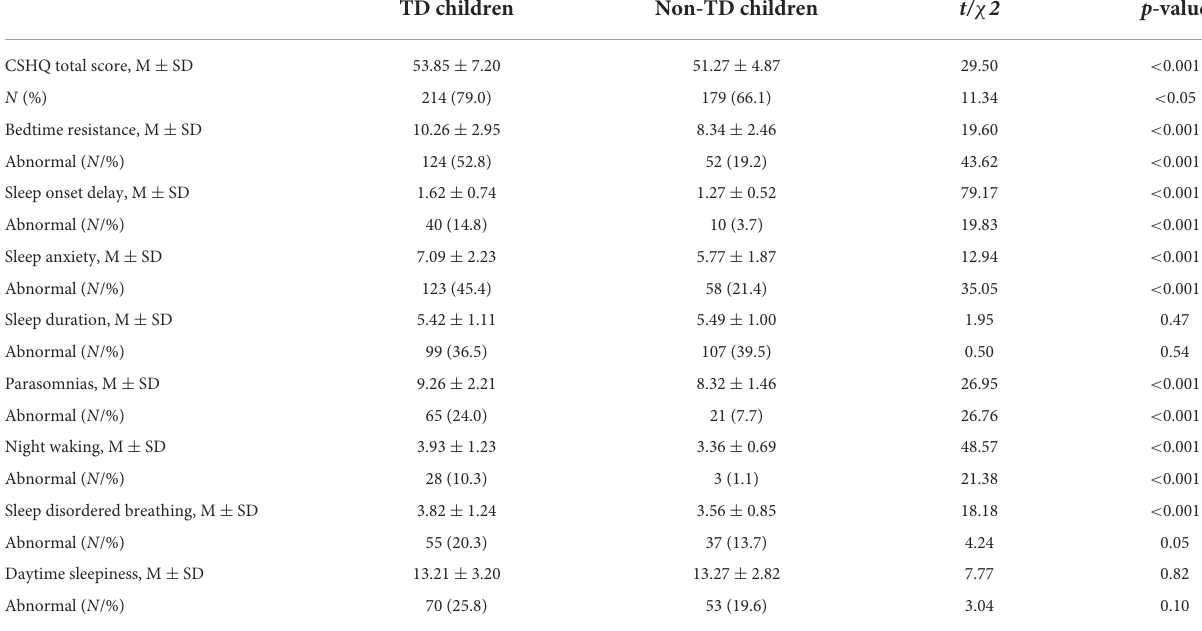
TABLE 3 Sleep disturbances in children with and without